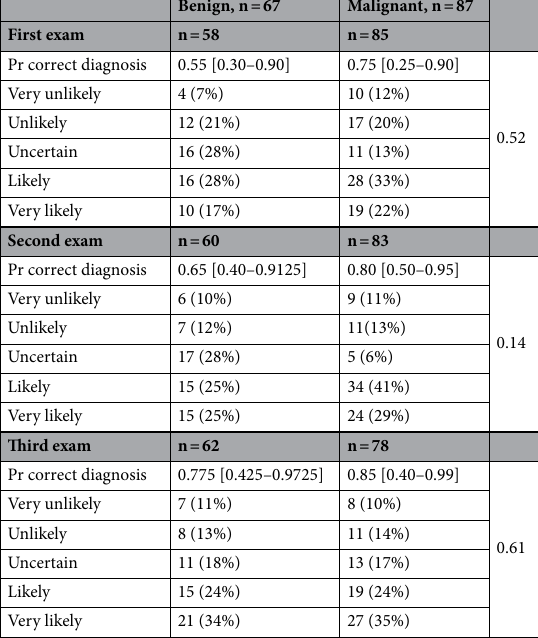
Table 4. Estimated probabilities of correct diagnoses along the sequence of exams according to the underlying diagnosis.